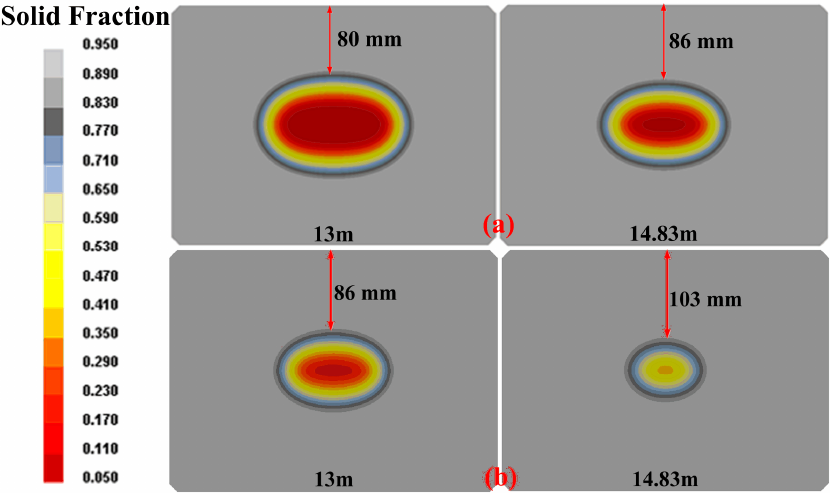
Figure 3. Photographs of sulfur printing samples for nail shooting experiments: ( a ) SSC (Super-slow cooling); ( b ) SC (Slow cooling).